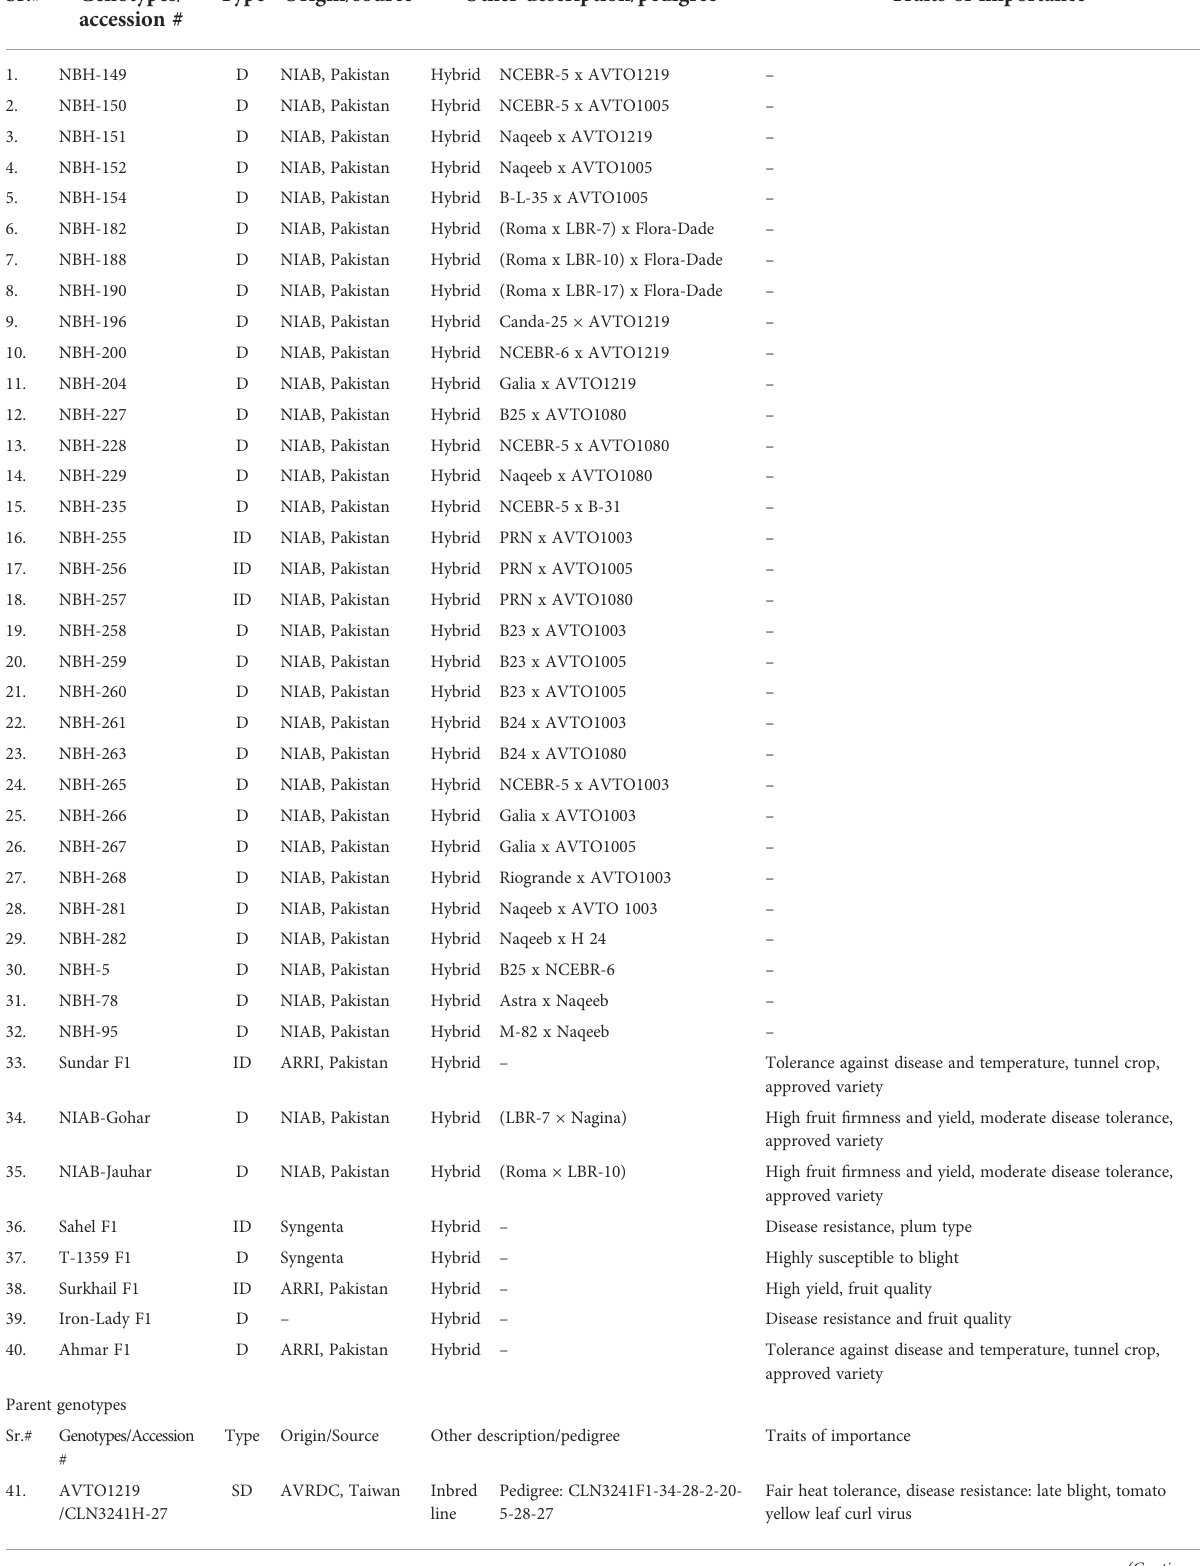
TABLE 1 Tomato genotypes used in the study.